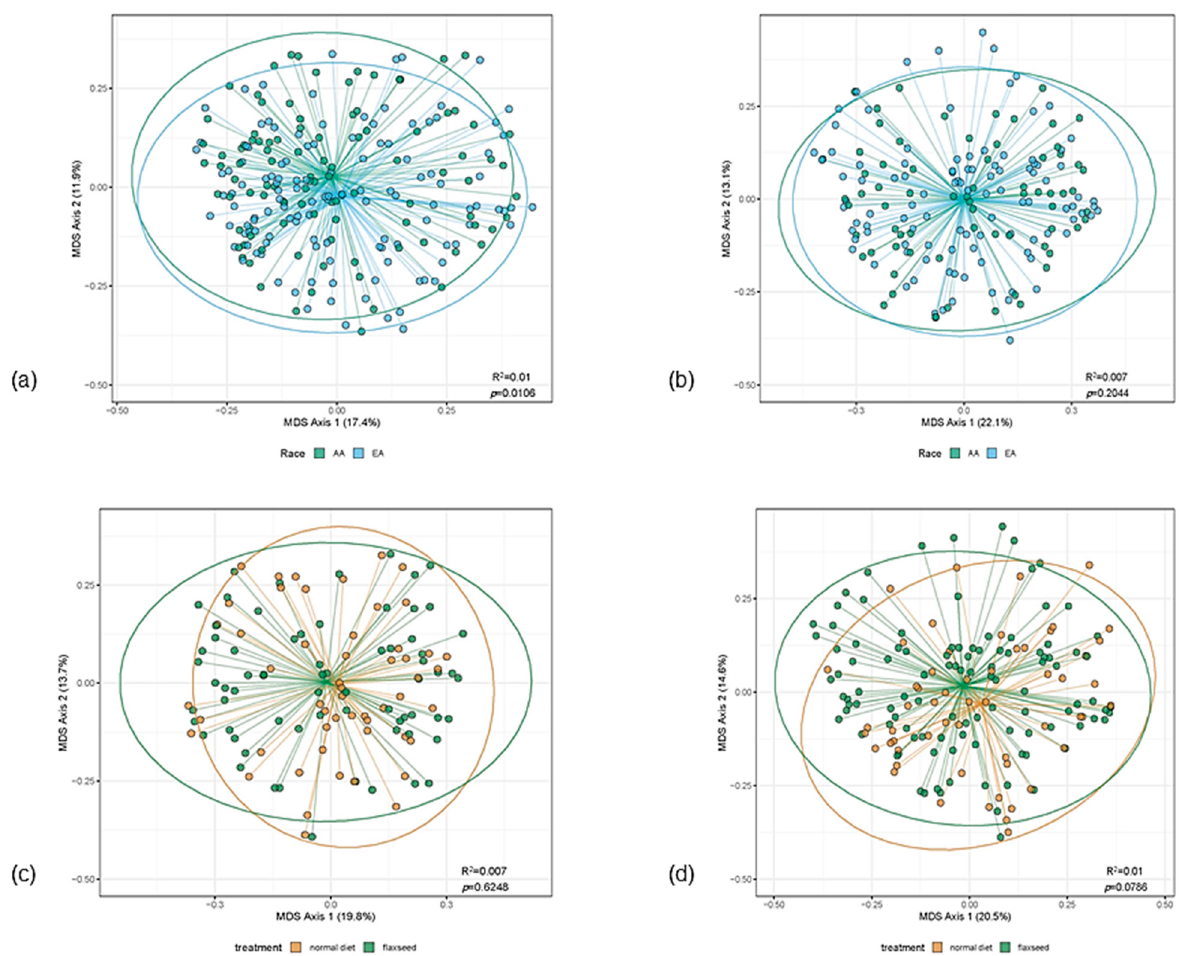
Figure 2. Beta diversity by ethnicity stratified by intervention status and by intervention status stratified by ethnicity. ( a ) shows beta diversity by ethnicity at baseline; ( b ) shows beta diversity by ethnicity after flaxseed (FS) intervention; ( c ) shows beta diversity by intervention status among women of African ancestry (AA); ( d ) shows beta diversity by intervention status among women of European ancestry (EA). Community structure differs by ethnicity at baseline (Figure 2a; p = 0.0106), but not after FS intervention (Figure 2b; p = 0.2044). A small amount of variation in community structure is explained by ethnicity differences (Figure 2a, R 2 = 0.01 and Figure 2b, R 2 = 0.007). Community structure does not differ significantly by intervention status for AA (Figure 2c) or EA (Figure 2d) women.